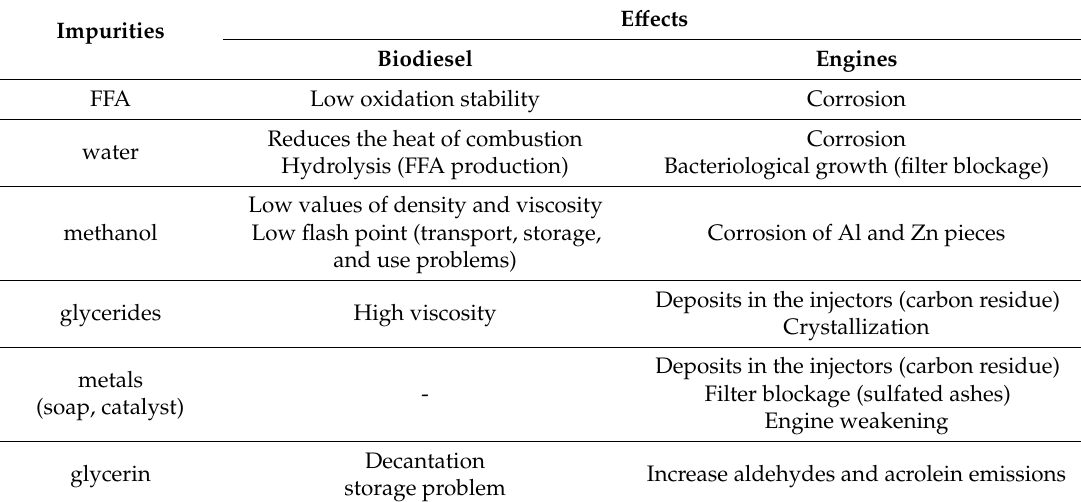
Table 8. Biodiesel impurities and properties e ff ects on internal combustion engines